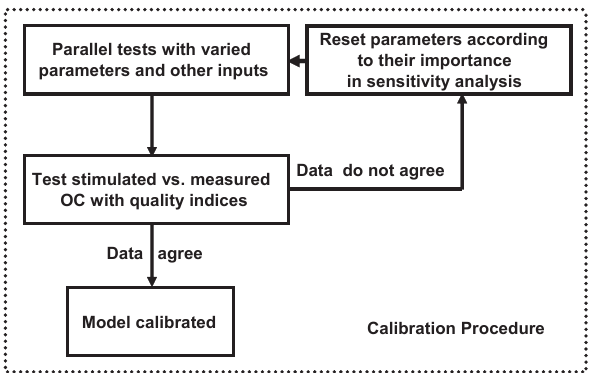
Fig. 2. Calibration procedure for OC cycle in SoilGen2 and the or- der of